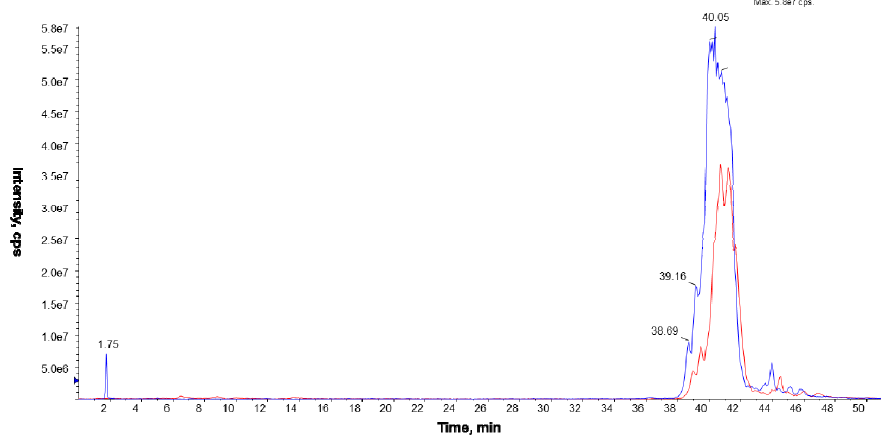
Figure 3. Chromatogram MS obtained with the Precursor Ion Mode for unlabeled (blue; m / z 184) and labeled (red; m / z 193) PC molecular species, recorded under NP LC/MS